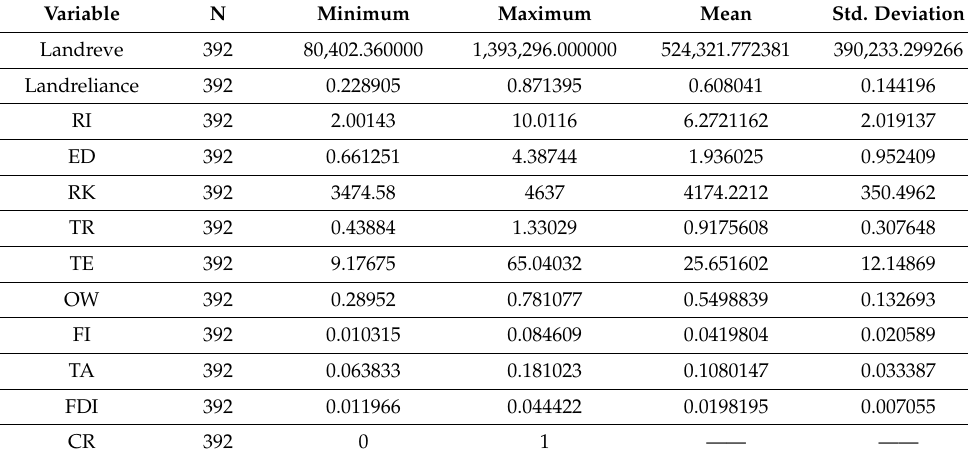
Table 1. Summary statistics of the